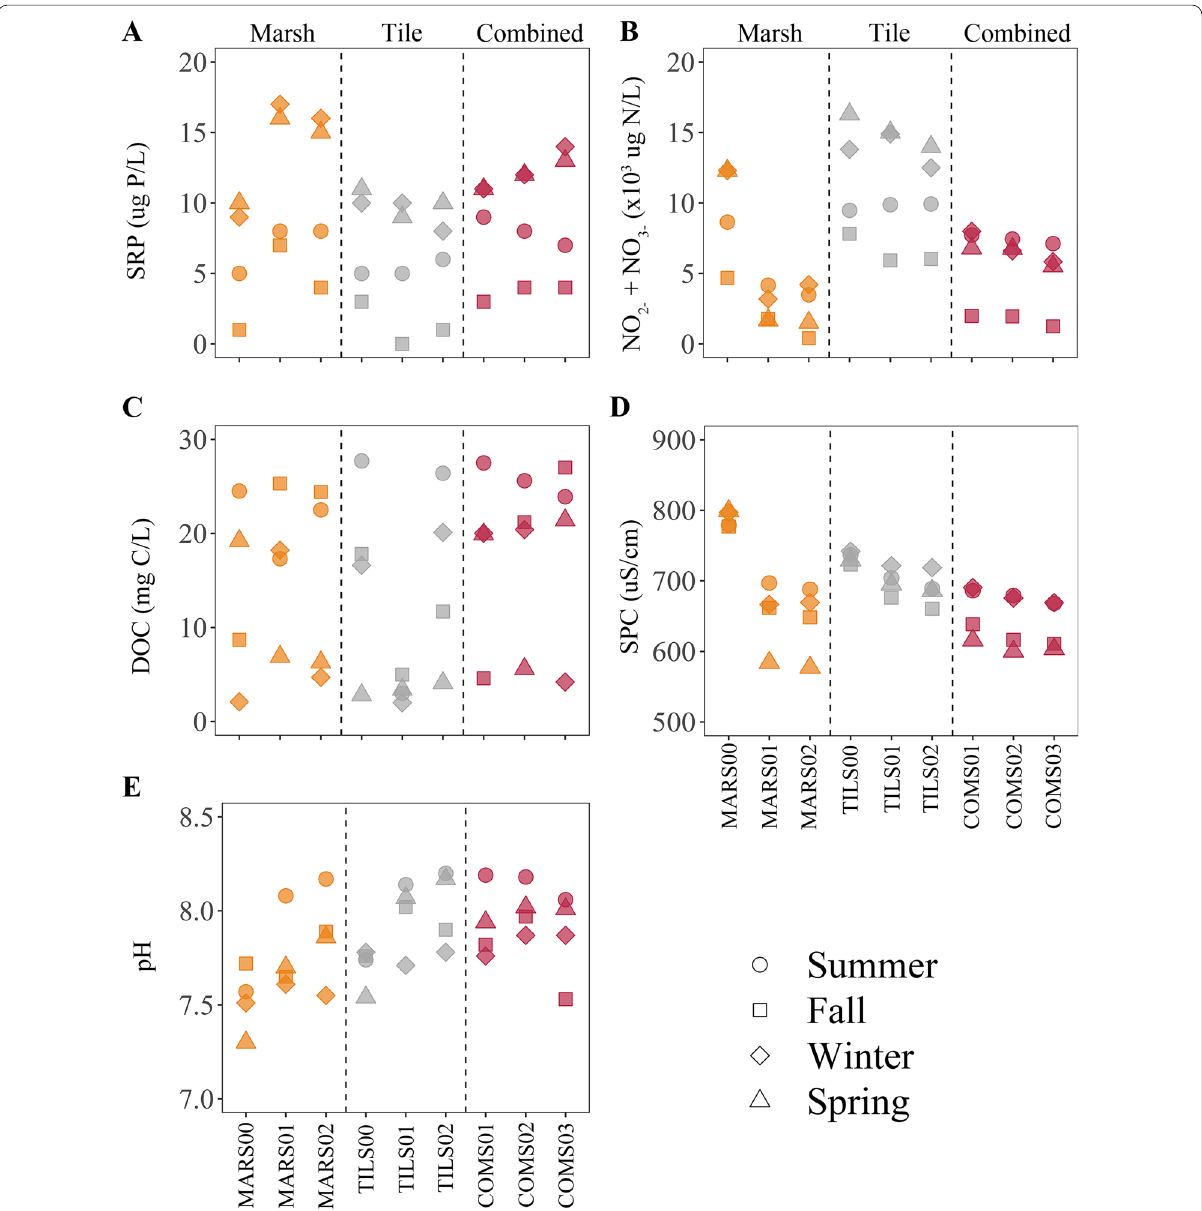
Fig. 6 Dot plots showing measured values of soluble reactive phosphorus (SRP; A ), nitrate-nitrite ( B ), dissolved organic carbon (DOC; C ), specific conductivity (SPC; D ), and pH ( E ) at the top, middle, and bottom positions of three segments sourced from the marsh (orange), agricultural tile drain (grey), and downstream trunk (magenta) comprising a headwater stream branch in southwestern Ontario, Canada. Samples collected in